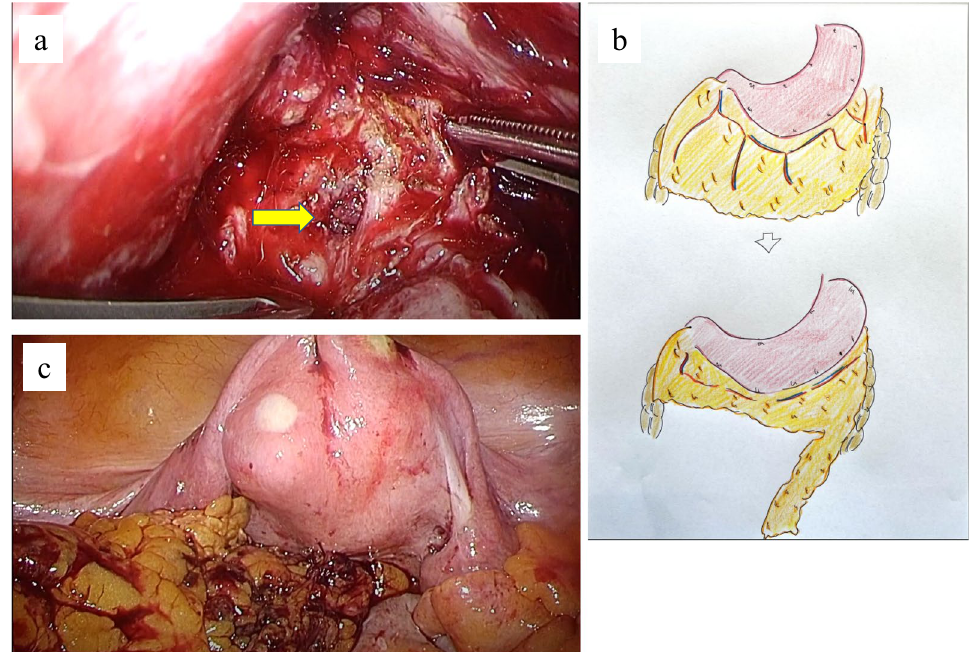
Fig. 3 A The leakage point in the rectum was sutured after resecting the fistula (arrow). B We designed the omentum which could reach the pelvis. C After covering the vagina and the rectum with the omentum flap